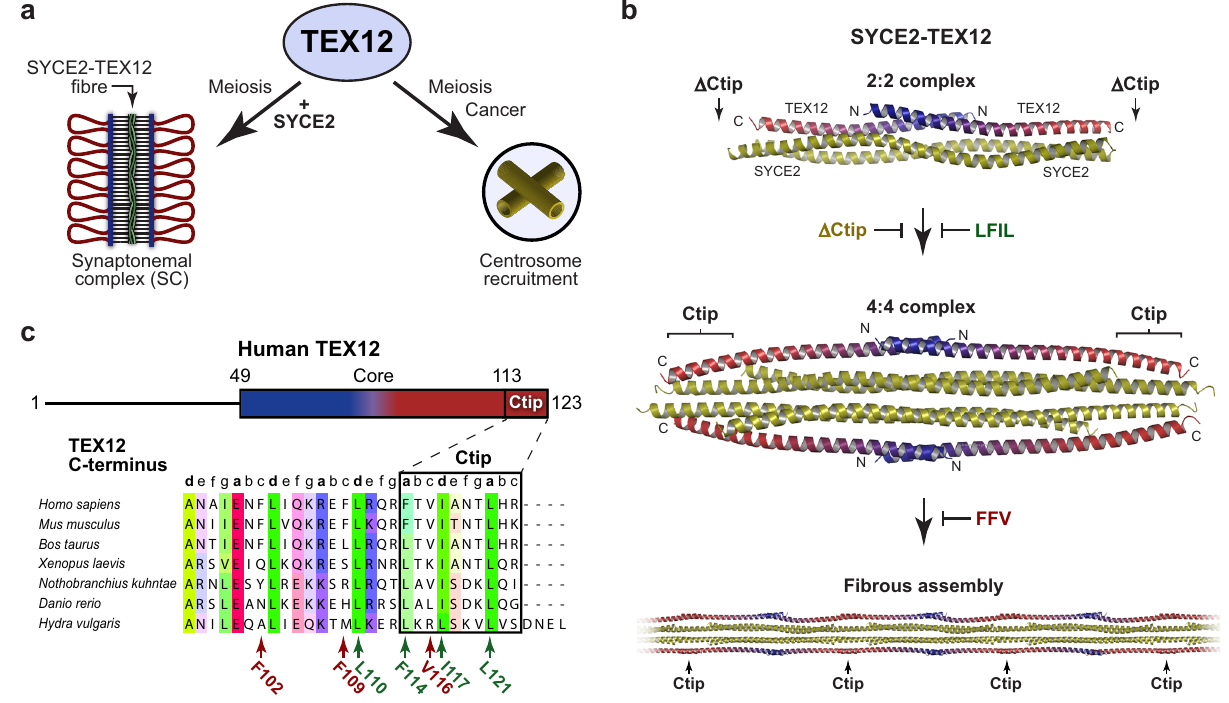
Fig. 1 TEX12 is a synaptonemal complex and centrosomal protein. a TEX12 has known cellular roles in meiotic chromosome synapsis and centrosome function. An SYCE2-TEX12 complex assembles into fi bres to provide the backbone of the synaptonemal complex (SC) that mediates meiotic chromosome synapsis 14 . TEX12 also undergoes SYCE2-independent recruitment to centrosomes during meiosis, and in cancer cells where it contributes to centrosome dysfunction 9 . b In the SC, TEX12 ’ s Ctip drives hierarchical assembly of SYCE2-TEX12 from a 2:2 complex to a 4:4 complex (blocked by TEX12 Δ Ctip and LFIL mutations), and into ‘ intermediate fi lament ’ -like fi bres (blocked by TEX12 FFV mutation) 14 . c Schematic of the human TEX12 sequence in which its structural core (amino-acids 49 – 123) and Ctip (amino-acids 114 – 123) are highlighted, alongside a sequence alignment of TEX12 ’ s C-terminus indicating heptad predictions and amino-acids mutated in this study (modi fi ed from ref. 14